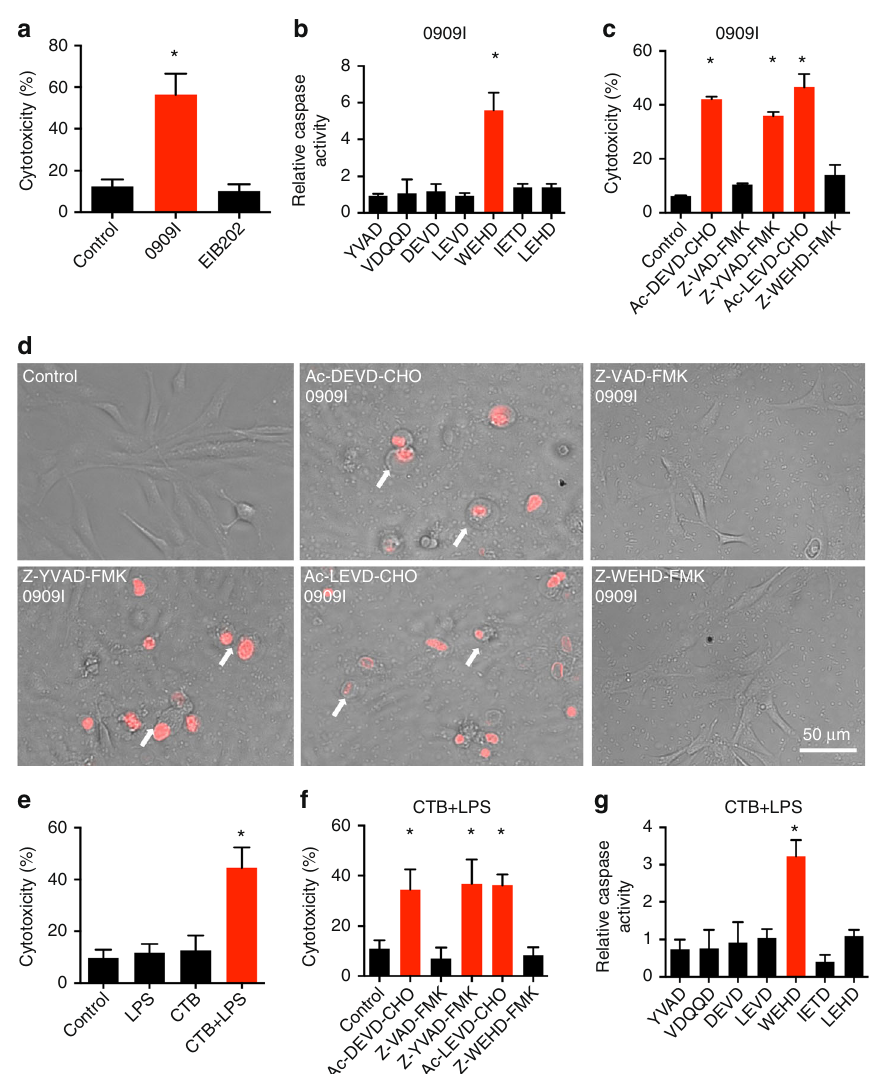
Fig. 1 Caspase-5-like activity is essential for pyroptosis in zebra fi sh fi broblasts. a ZF4 zebra fi sh fi broblasts were infected with wild-type (EIB202) or 0909I E. piscicida for 2 h at a multiplicity of infection (MOI) of 50, or left uninfected. Supernatants from the indicated ZF4 cells were analyzed for cell death, as measured by lactate dehydrogenase (LDH) release. b ZF4 cells were infected with 0909I E. piscicida for 2 h at an MOI of 50. Relative caspase activity was then measured by incubating cell lysates with fl uorogenic and chromogenic substrates of caspase-1 (YVAD), caspase-2 (VDQQD), caspase-3/7 (DEVD), caspase-4 (LEVD), caspase-5 (WEHD), caspase-8 (IETD), and caspase-9 (LEHD). c , d ZF4 cells were treated with caspase-3/7, pan-caspase, caspase-1, caspase-4, and caspase-5 inhibitors (Ac-DEVD-CHO, Z-VAD-FMK, Z-YVAD-FMK, Ac-LEVD-CHO, and Z-WEHD-FMK, respectively). c LDH release for cell death was measured 2 h after 0909I E. piscicida infection. d Images were taken after 0909I E. piscicida infection for 2 h. Propidium iodide (PI) was added to detect the loss of plasma membrane integrity. Arrows indicate cells exhibiting pyroptotic-like features. Scale bar, 50 µ m. e – g ZF4 cells were primed with Pam3CSK4 for 4 h, before being stimulated with cholera toxin B subunit (CTB) plus LPS, LPS, or CTB alone for 12 h. e Supernatants from the indicated ZF4 cells were analyzed for cell death, as measured by lactate dehydrogenase (LDH) release. f Cytosolic LPS-delivered ZF4 cells were treated with indicated caspase inhibitors as in Fig. 1c, Supernatants from the indicated ZF4 cells were analyzed for cell death, as measured by lactate dehydrogenase (LDH) release. g Relative caspases activity was measured by incubating cell lysates with indicated fl uorogenic and chromogenic substrates as in Fig. 1b. a – g Results are representative of at least three independent experiments, and error bars denote the SD of triplicate wells. * p < 0.05 ( t test)